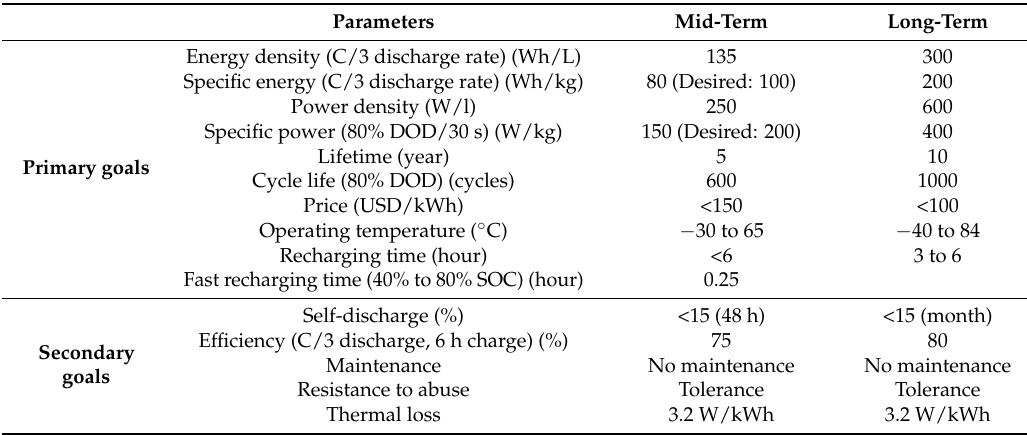
Table 5. Performance goal of EV batteries as set by USABC. Data from